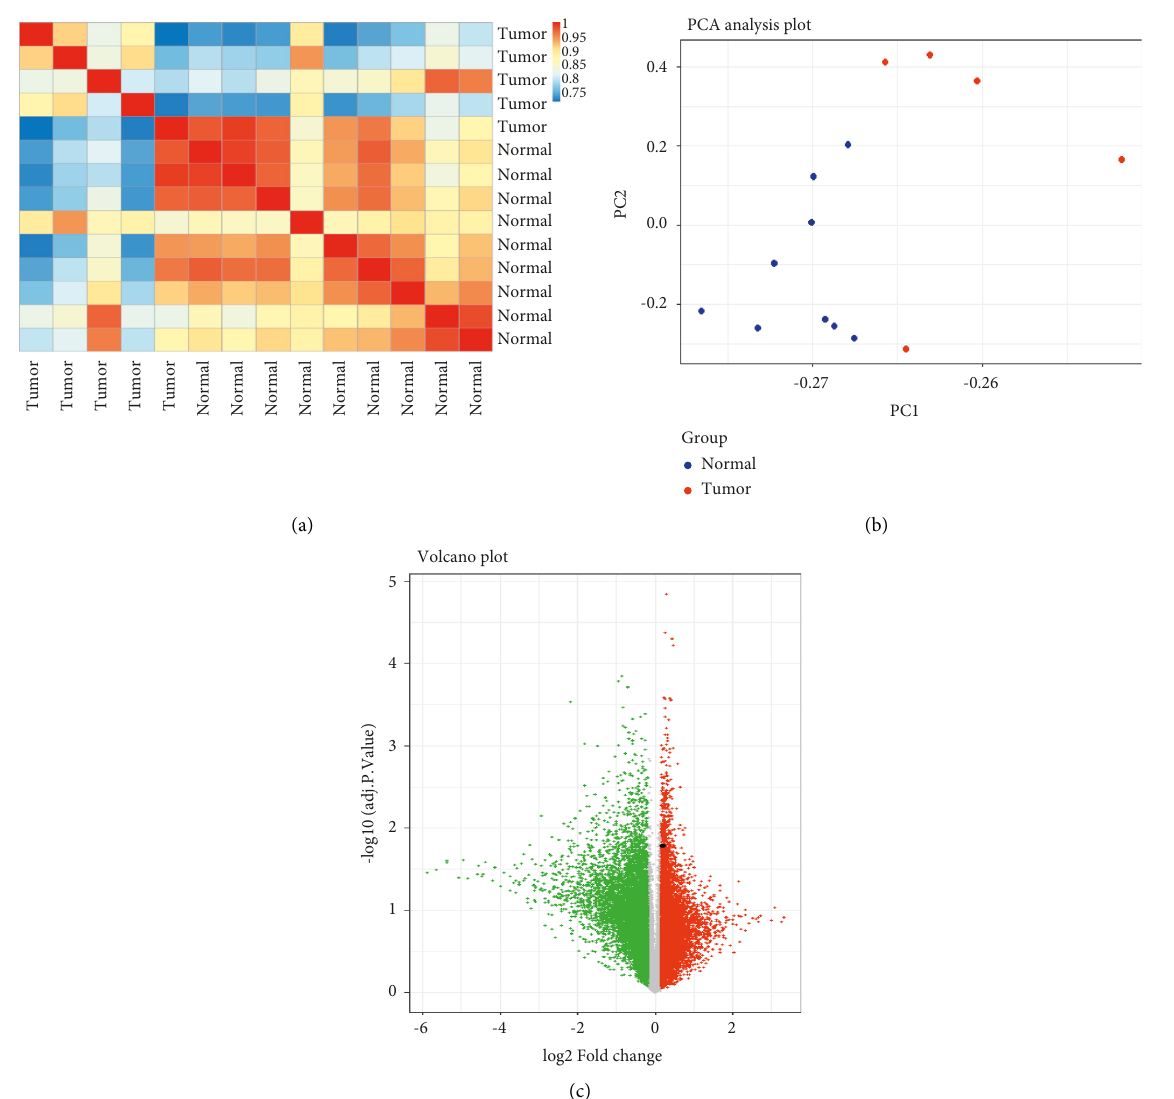
Figure 2: Analysis of DEGs in dataset GSE71053 using R software (a, b, c). (a) The heatmap figure represents the correlation between the two groups normal and BC in 54675 DEGs; (b) principal component analysis (PCA) between healthy and BC tissues based on the GSE71053 dataset. (c) Volcano plot of DEGs in the GSE71053 dataset. SFN is showed by a black dot in the graph. X -axis represents log2 fold change (FC) and Y -axis represents − log10 (adjusted p value). Red dots depict the low expression of genes ( n � 8711), and green dots indicate the high expression of genes ( n � 8712) in the GSE71053